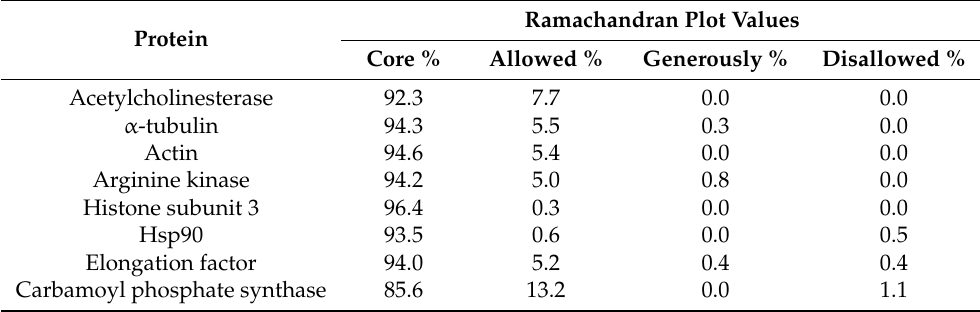
Carbamoyl phosphate